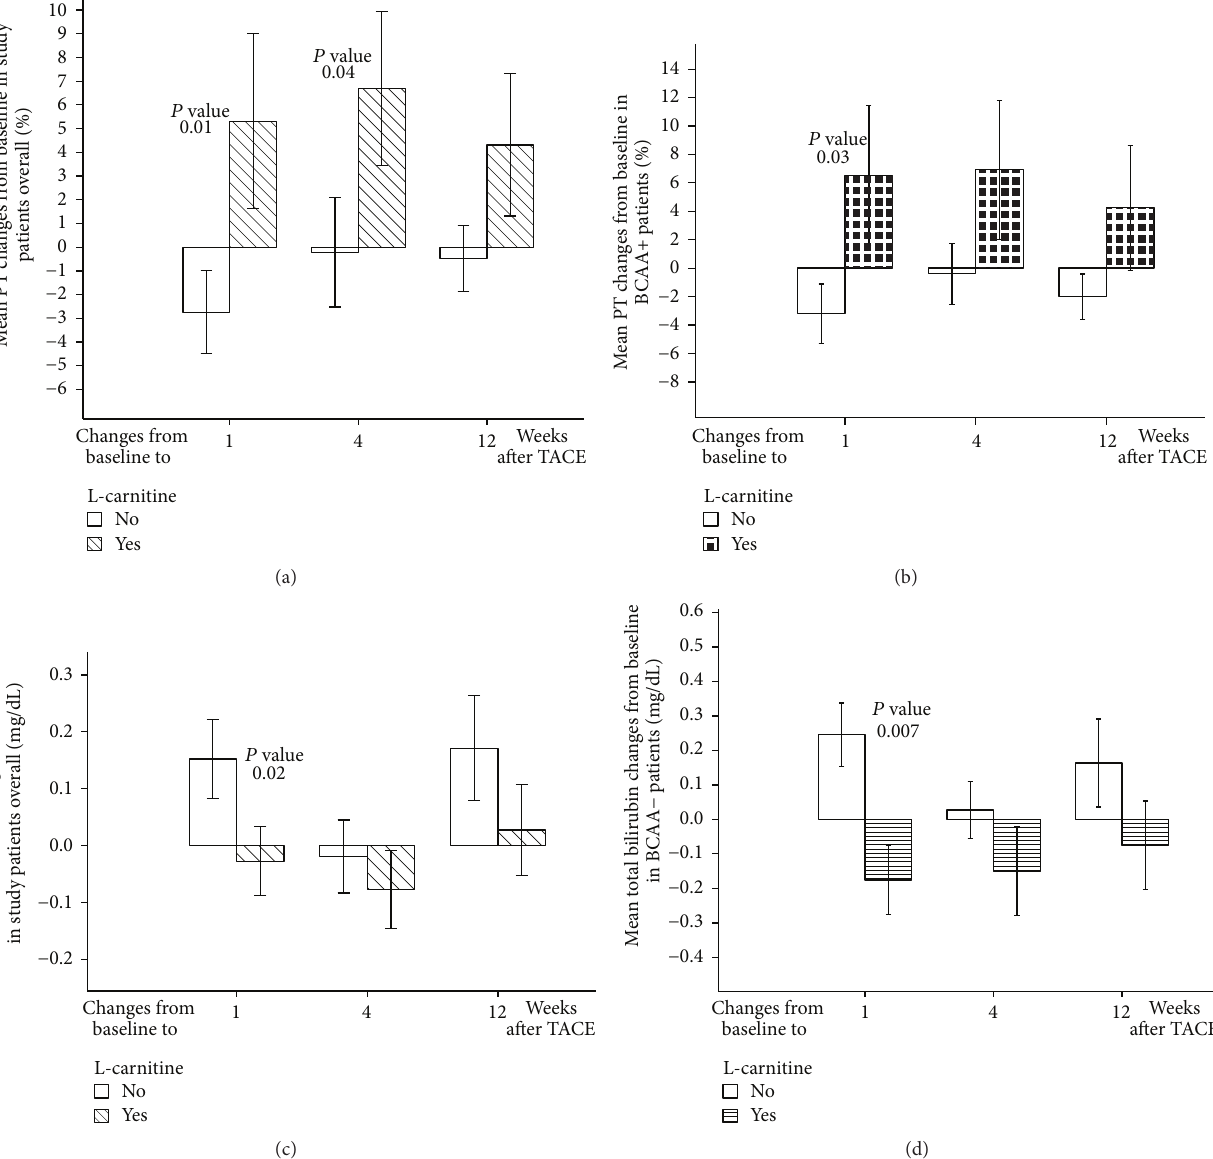
Figure 2: L-carnitine effects on PT and total bilirubin. (a) L-carnitine effects on mean PT changes from baseline in study patients overall. (b) L-carnitine effects on mean PT changes from baseline in BCAA+ patients. (c) L-carnitine effects on mean total bilirubin changes from baseline in study patients overall. (d) L-carnitine effects on mean total bilirubin changes from baseline in BCAA − patients. Footnote: PT: prothrombin time; TACE: transarterial chemoembolization. Error bars represent standard